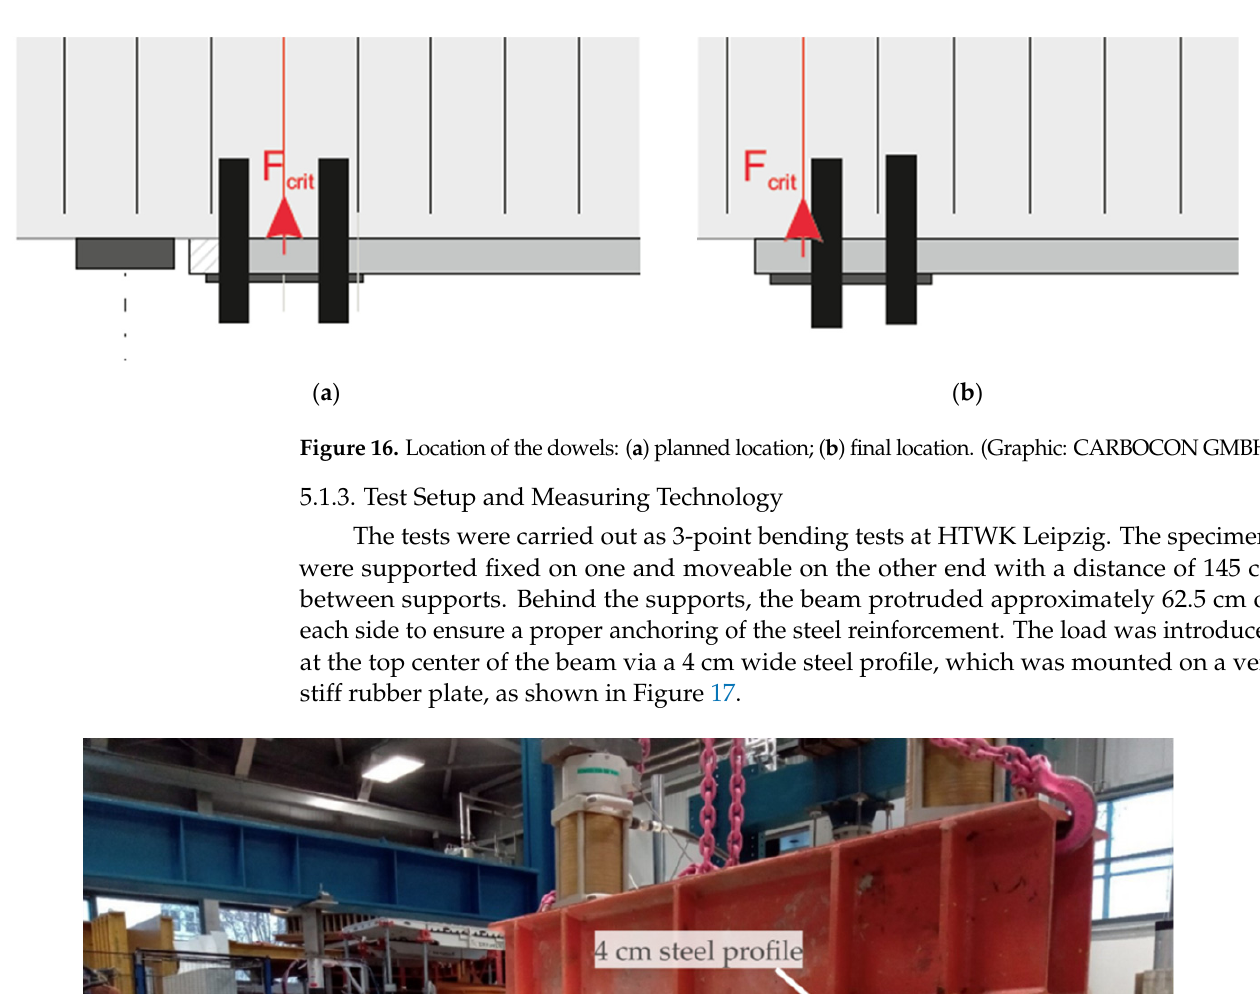
Figure 16. Location of the dowels: ( a ) planned location; ( b ) final location. (Graphic: CARBOCON GMBH).